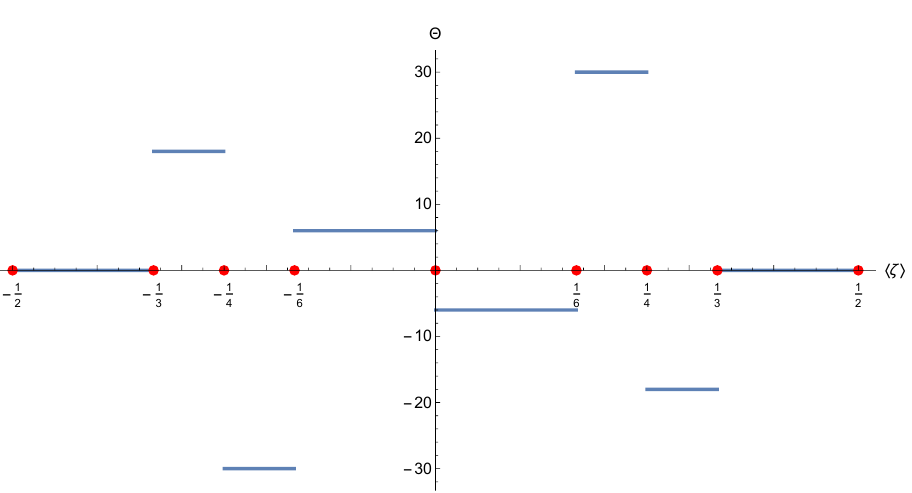
Figure 2 . Plot of the value of the CS coe(cid:14)cient (cid:2) af , given in (2.23), with charges being the hypercharges of the Standard Model, as a function of the Coulomb branch parameter h (cid:16) i , over the fundamental period h (cid:16) i 2 q a h (cid:16) i 2 Z , where at least a fermion is